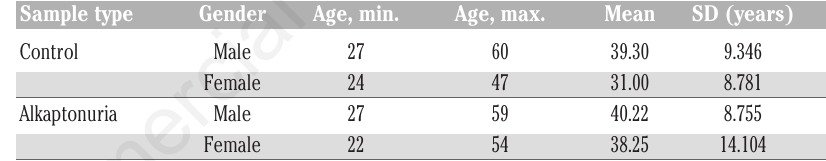
Table 1. Summary of the sample.